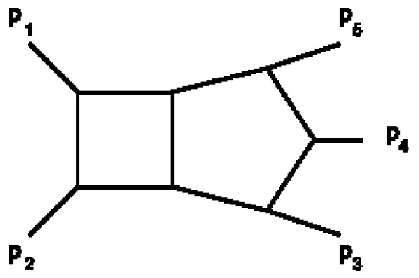
Figure 17. Massless planar